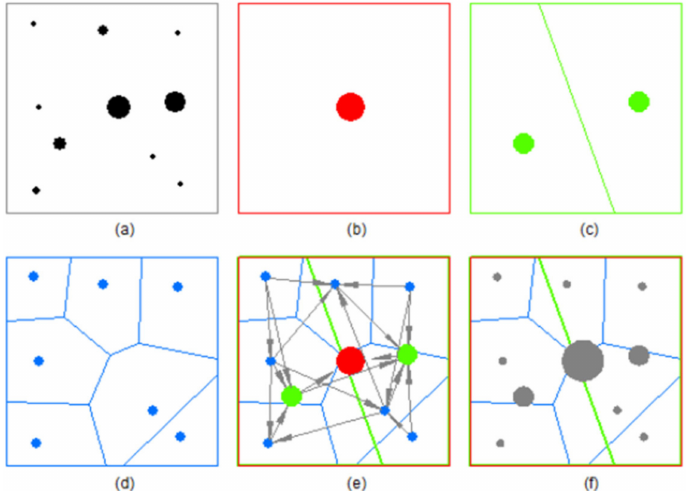
Figure 2. (Color online) The ten fictitious cities and their interrelationship constitute a living structure. (Note: As a structural invariant of the central place theory model (Christaller 1933) [5], the cluster of the ten cities ( a ) is composed of the largest city ( b ) bounded by the red square, surrounded by two middle-sized cities ( c ) separated by the green line and bounded by the green box, and further surrounded by seven smallest cities ( d ) separated by blue lines and bounded by the blue box, thus with three hierarchical levels, indicated by dot sizes and colors. Because of mutual relationship among the ten cities ( e ), each city has di ff erent degree of life, as indicated by the dot sizes ( f